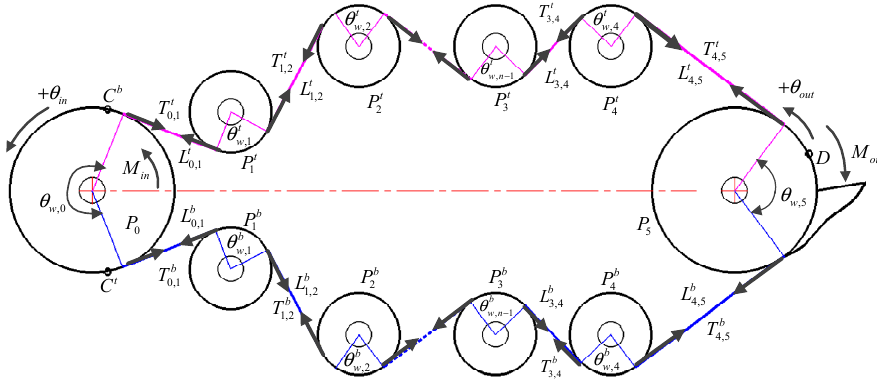
Figure 5. Closed-circuit cable-pulley system.